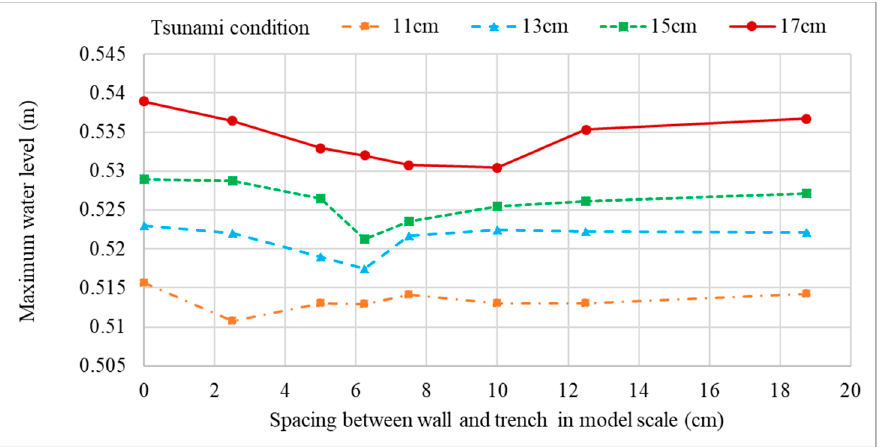
Figure 23. Comparison of maximum water levels observed at location D for different tsunami Figure23. ComparisonofmaximumwaterlevelsobservedatlocationDfordi ff conditions.